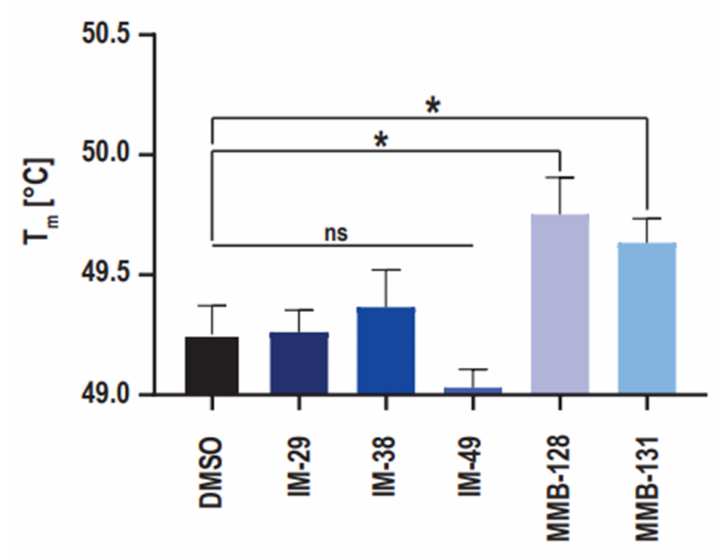
Figure 5. NAPRT inhibitors MMB-128 and MMB-131 directly engage recombinant hNAPRT. Dif- ferential scanning fluorimetry (DSF) was used to determine the thermal stabilization of hNAPRT protein upon inhibitor binding. Recombinant hNAPRT protein was exposed to 100 µ M hNAPRT inhibitors over a defined temperature gradient and the melting temperature Tm was calculated for each compound. The data are shown as means ± standard error of the means (SEM) of two technical replicates with three biological replicates each. * p < 0.05; unpaired t